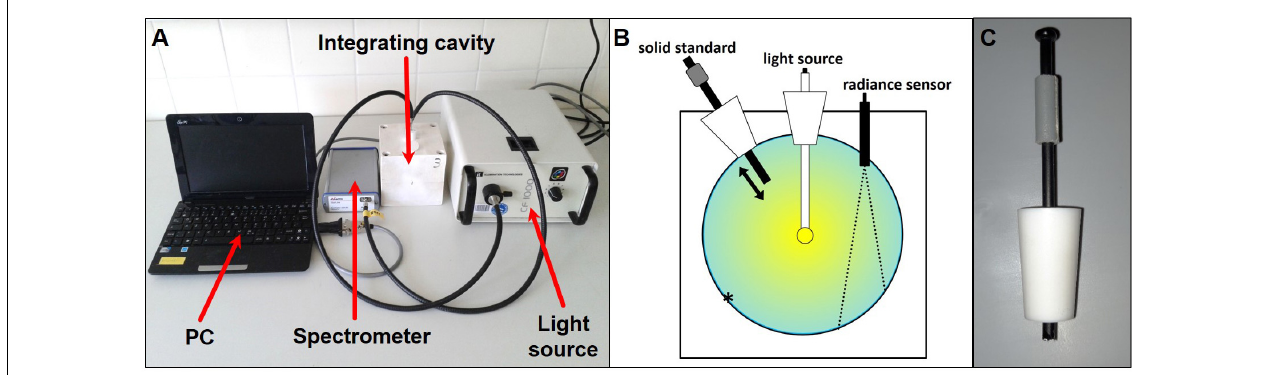
FIGURE 1 | Point-source integrating-cavity absorption meter (PSICAM). (A) Principal setup. (B) Schematic longitudinal section through the PSICAM cavity equipped with the solid standard. The star marks the spot where the reflectivity was altered locally by a piece of black tape; the dotted lines indicate the field of view of the detector. (C) PSICAM solid